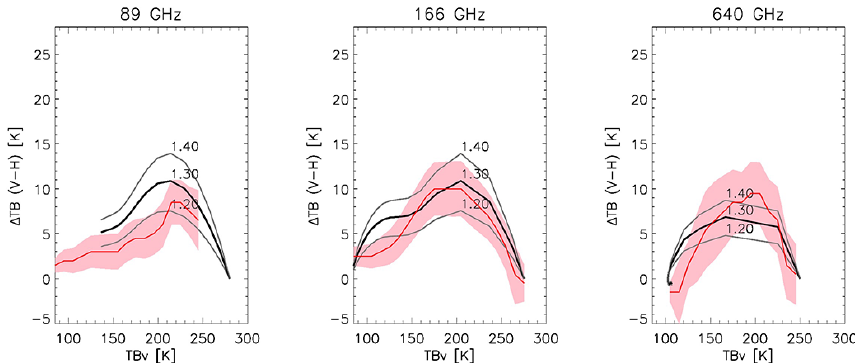
Figure 8. CRM simulated PD–TB V curves in black for AR values of 1.2, 1.4, (thin) and 1.3 (bold), overlaid on top of the GMI and CoSSIR observations in red for (a) 89, (b) 166, and (c) 640GHz with the standard deviation shown in pink shades. Surface contaminations are removed using the cloud flag derived from the 183.3 ± 3GHz channel.